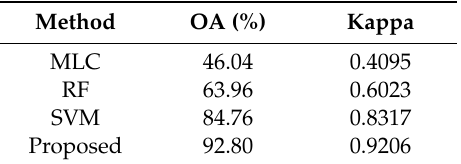
Table 8. Comparison with classical machine learning